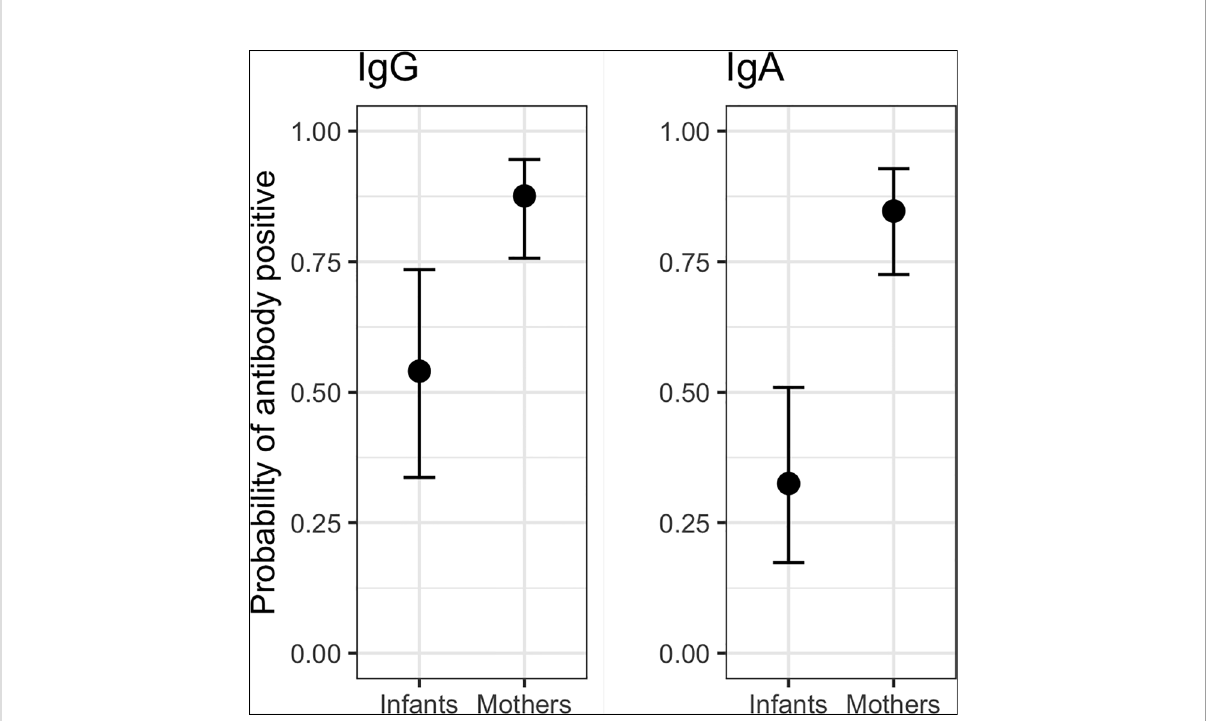
FIGURE 3 Predicted mean probability (with 95% credible intervals) of IgG and IgA seropositivity across all samples collected from COVID+ mothers (n = 36, n obs = 116) and their exposed infants (n = 25, n obs = 66). IgG infant = 0.54 [0.33 – 0.74], IgG maternal = 0.87 [0.76 – 0.95]. IgA infant = 0.33 [0.17 – 0.52]; IgA maternal = 0.85 [0.72 –